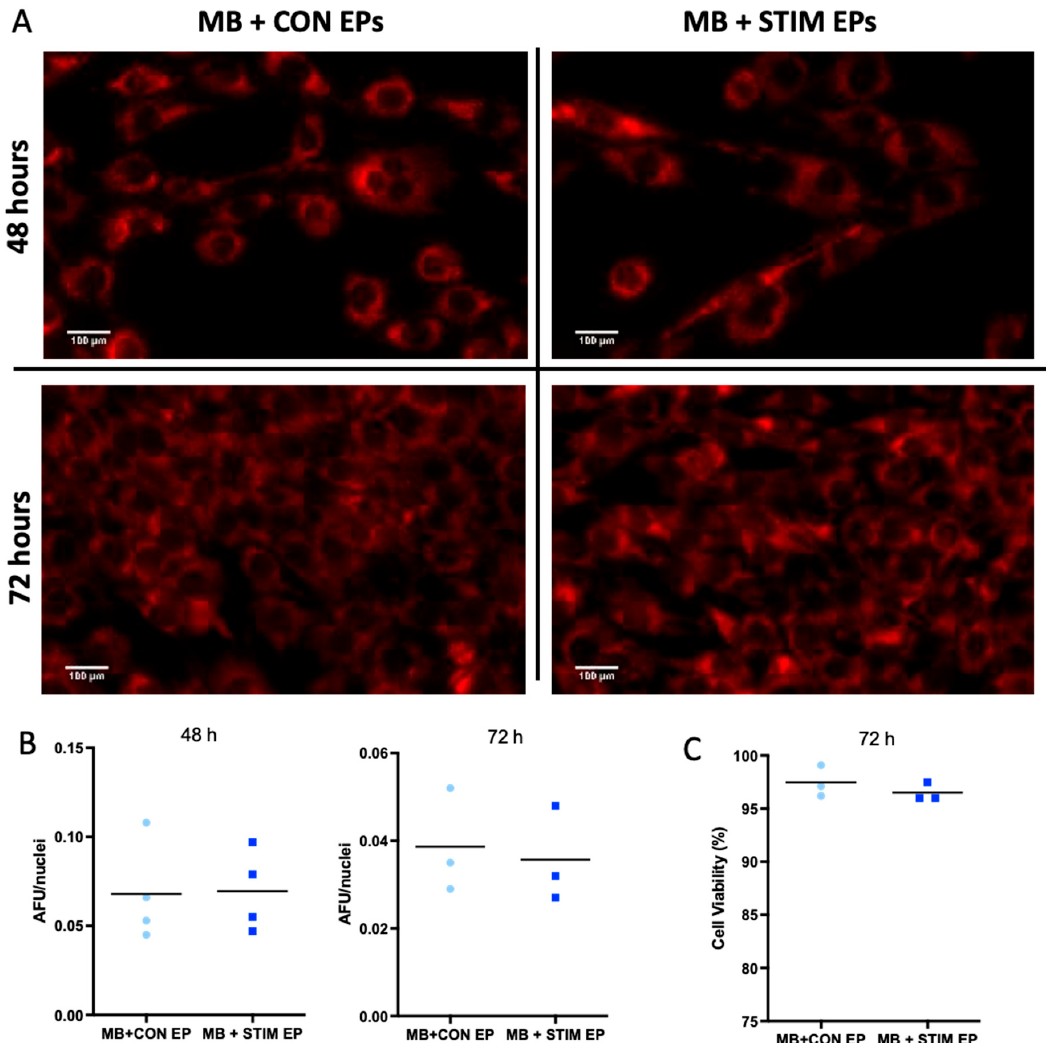
Figure 6. Mitochondrial content and cell viability in myoblasts (MB) treated with EPs from CON vs. STIM myotubes. Myoblasts were treated with EPs (13 µg/well) isolated from conditioned media (using Total Exosome Isolation Reagent (ThermoFisher, Waltham, MA, USA) from non-stimulated control (CON) vs. acutely stimulated (STIM) myotubes for 48 h and 72 h and changes in mitochon- drial mass measured. ( A ) Representative fluorescent images of myoblasts stained with MitoTracker Red CMXRos after 48 h and 72 h of EP treatment from CON and STIM myotubes taken at 10× mag; scale bar = 100 µm. ( B ) Quantification of fluorescent images showed no change in mitochondrial content with STIM myotube-EP treatment. Images were normalized to nuclei count by dividing total fluorescence of each image by number of nuclei and expressed as arbitrary fluorescent units (AFU) per nuclei ( n = 3–4). ( C ) Cell viability, determined by trypan blue exclusion and expressed as % viable cells remained unchanged between CON vs. STIM treated myoblasts ( n = 3). Data were ana- lyzed using an unpaired Student’s t test, and are expressed as scatter plots with mean.